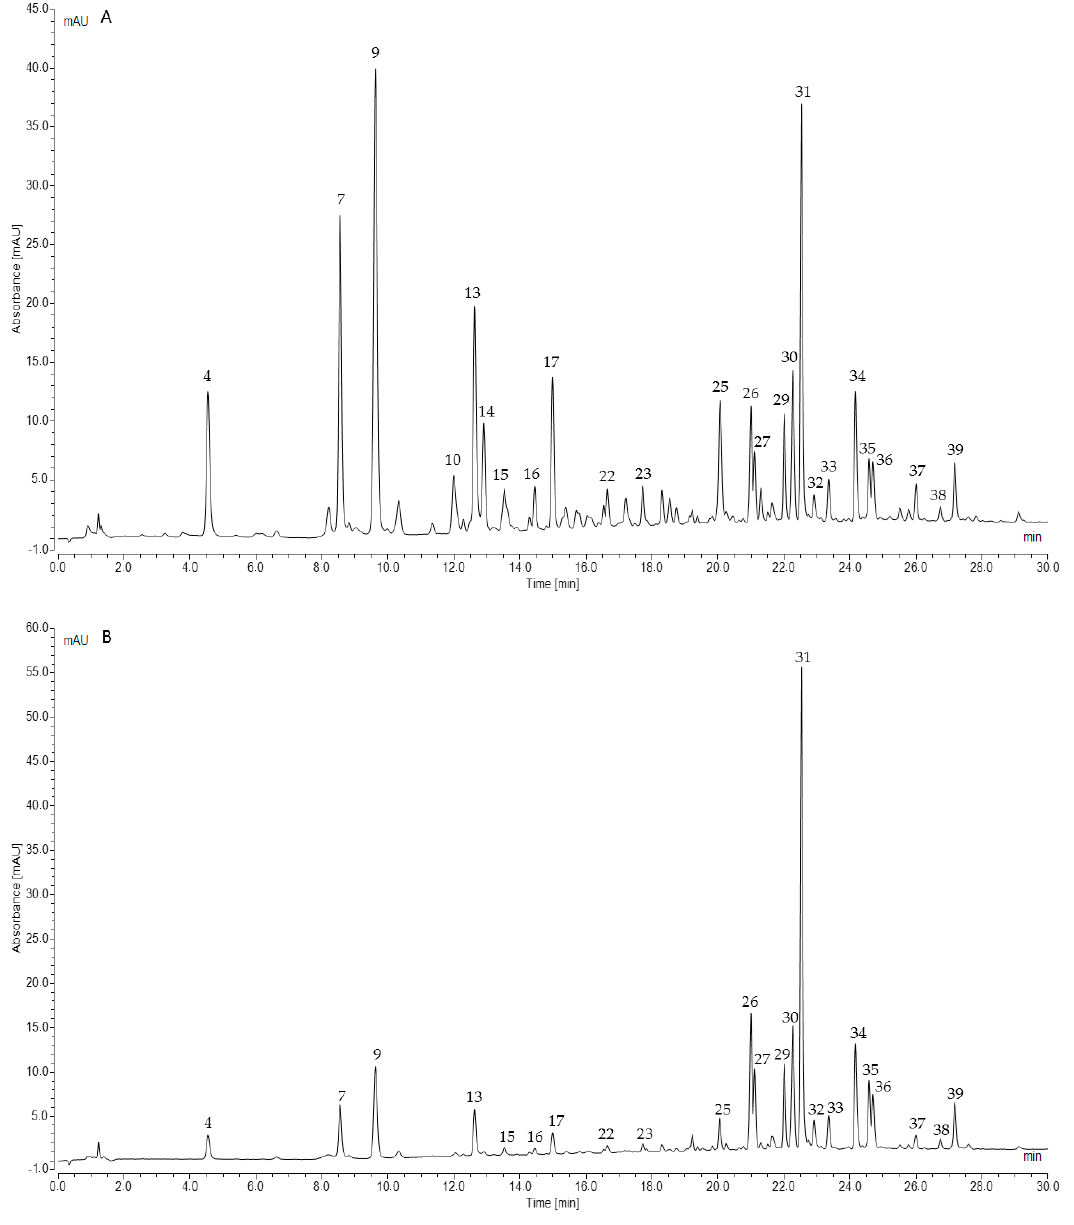
Figure 3. Representative UHPLC chromatograms of G. officinalis water infusion at 320 nm ( A ) and 360 nm ( B ).